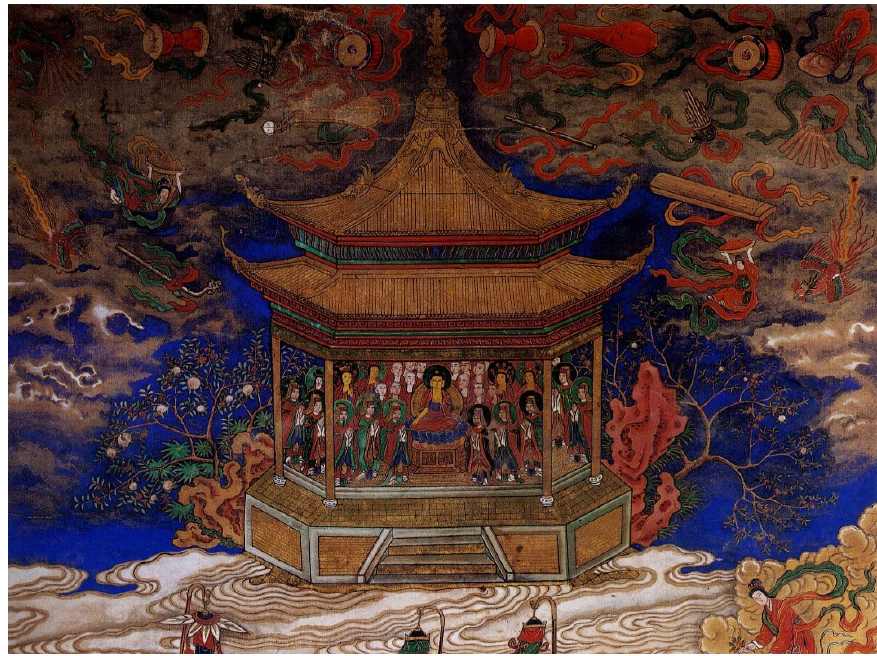
Figure 20. Detail of Three Gates in a Single Mind showing the Palace of Tu ṣ ita Heaven in the left frame. After (Sŏngbo Munhwajae Yŏn’guwŏn 1997, p. 185).